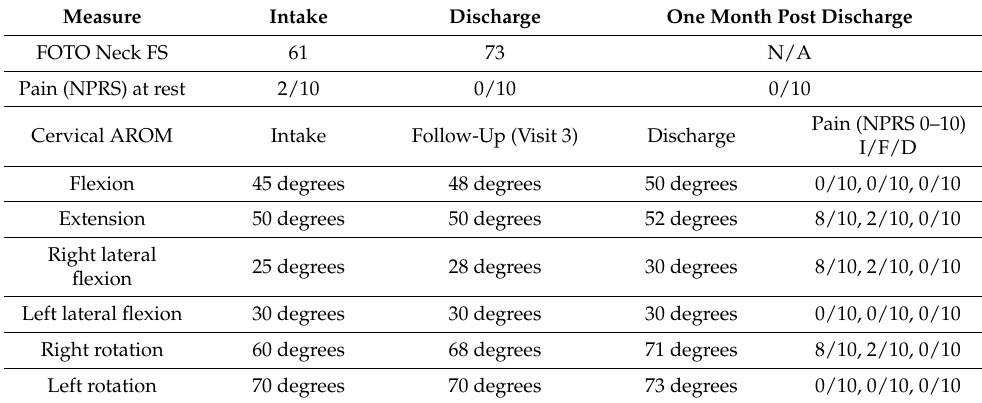
Table 3. Outcome measures from intake to discharge.